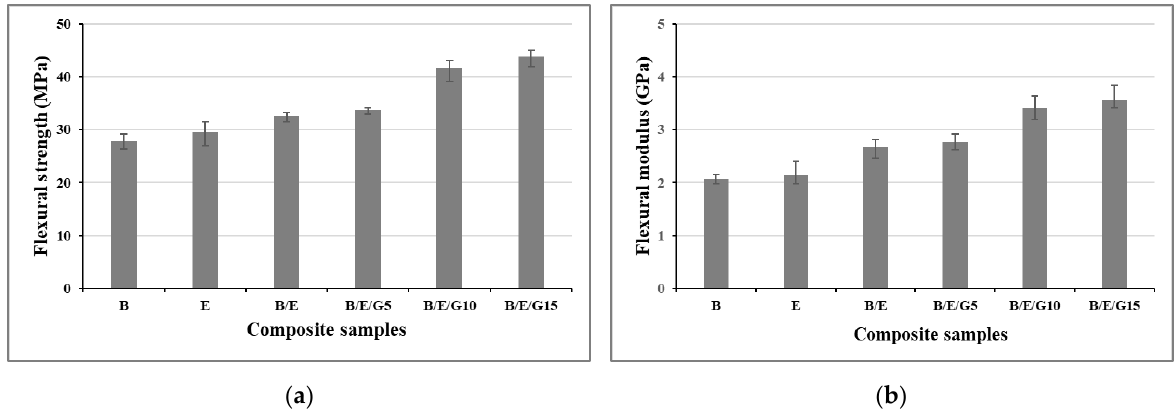
Figure 6. Flexural strength ( a ) and flexural modulus ( b ) of basalt and E-glass composite samples.